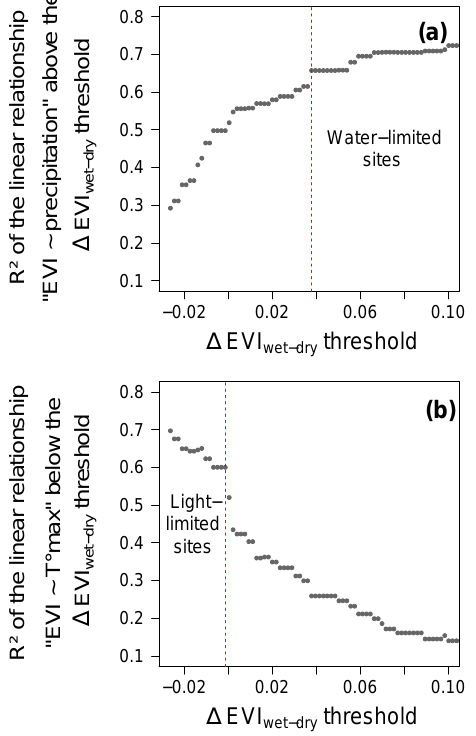
Figure 6. Threshold of (cid:49) EVI wet-dry used to define “water-limited” sites (a) and “light-limited” sites (b) . Sites with (cid:49) EVI wet-dry be- tween the two thresholds had a mixed influence of the two climate variables and were qualified as “mixed”. The names of the classes represent the main climate limitations deduced from the climate control on canopy photosynthetic capacity observed in our results. The y axis represents the R 2 values of the linear models normalized EVI as a function of normalized precipitation (a) and as a func- tion of maximal temperature (b) , respectively for the sample with (cid:49) EVI wet-dry above the threshold (a) and below the threshold (b) . Optimal threshold of (cid:49) EVI wet-dry for climate variable influence on normalized EVI was defined by a break in the decrease of R 2 val- ues, which is represented by red dashed